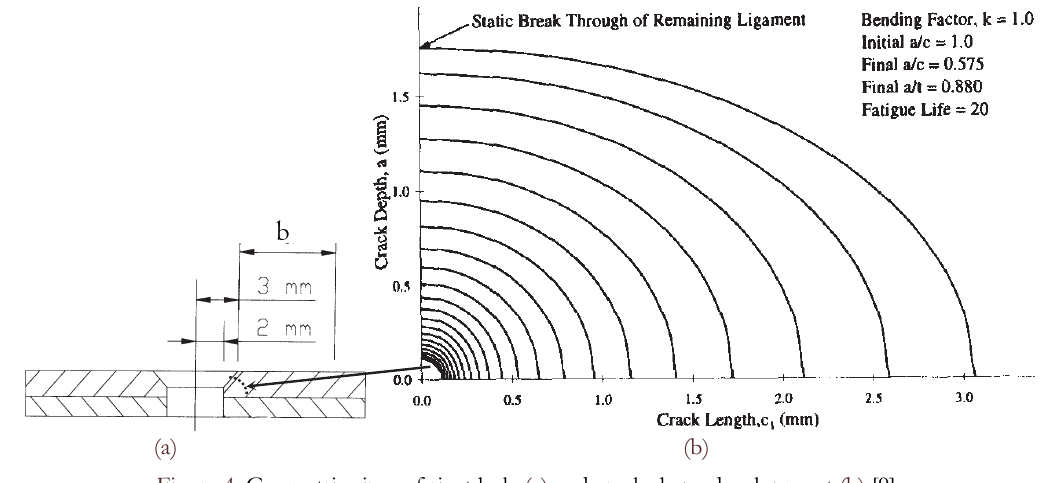
Figure 4: Geometric sizes of rivet hole (a) and crack shape development (b)